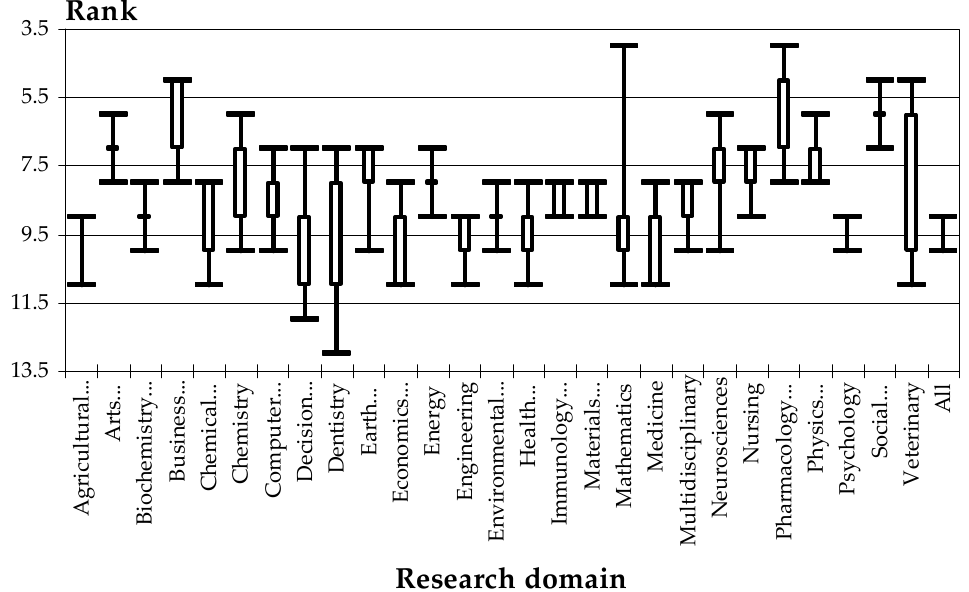
Figure 8. The number of documents published in different fields in Slovenia during 2010–2018. The figure displays boxplots of the ranks of fields computed for each year separately. Results indicate that the values are in the middle part of the ranking.